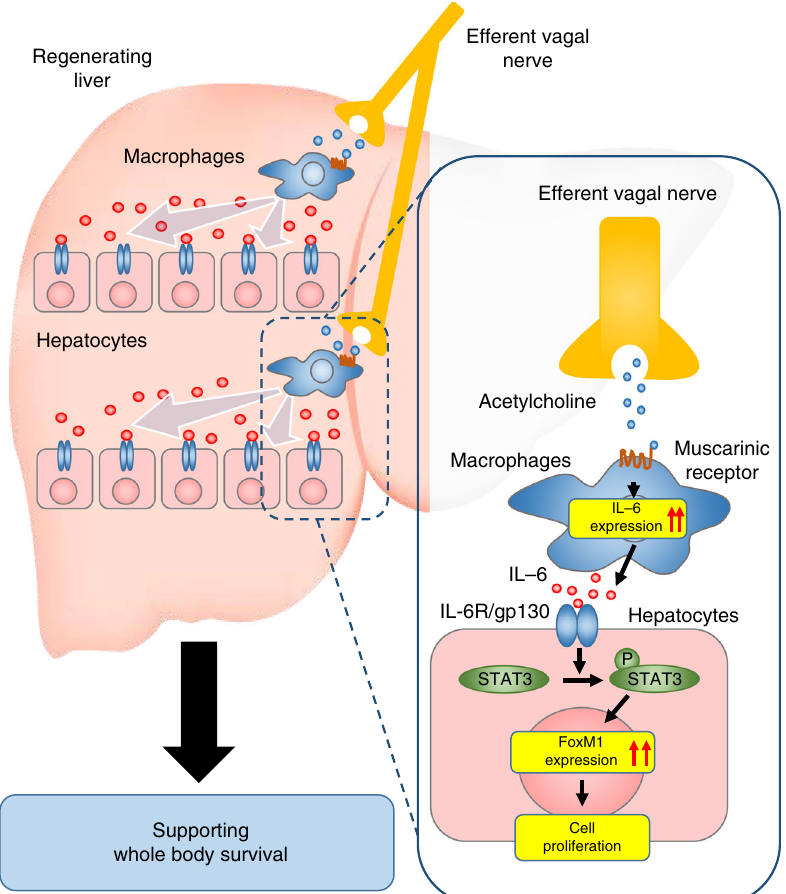
Fig. 8 The proposed mechanism of vagus-mediated liver regeneration. The multistep regulatory mechanism of acute liver regeneration after PHx via